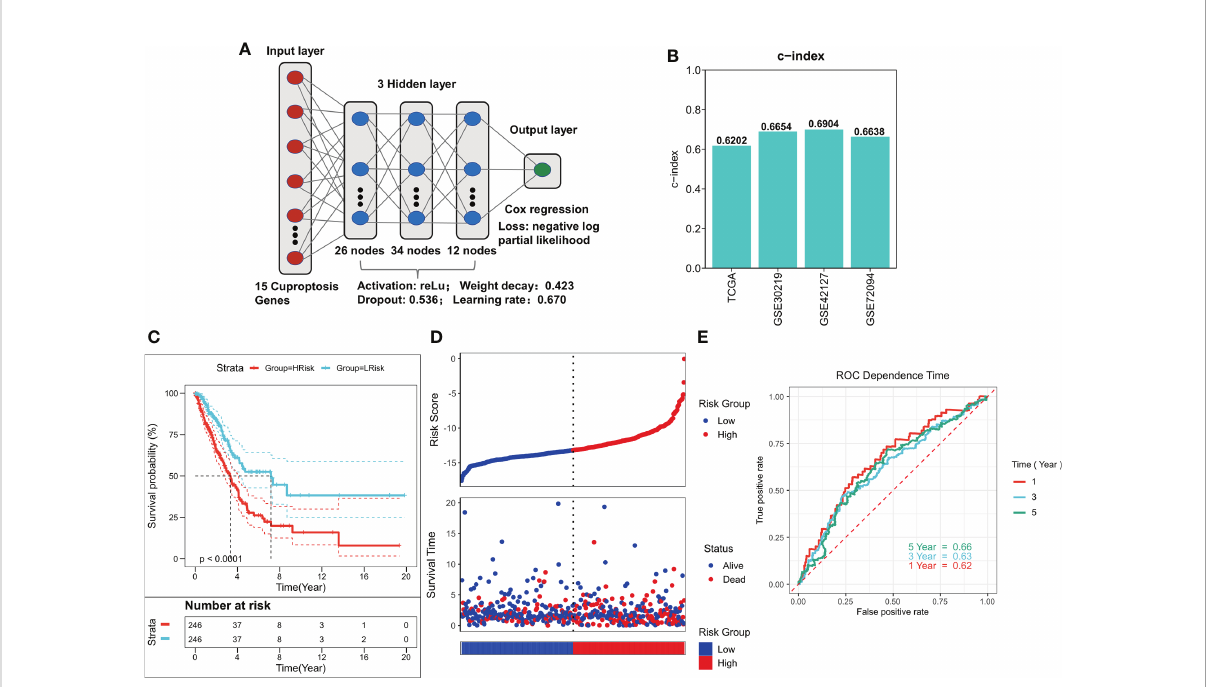
FIGURE 3 Construction of deep learning model related to CRGs. (A) Schematic diagram of the optimum ANN model. (B) C-INDEX of the optimum ANN model in the TCGA and GEO cohorts. (C) KM survival curves of the high-risk and low-risk groups in the TCGA cohort. (D) Survival status of patients in the TCGA cohort. (E) ROC curves of risk score at 1, 3, 5, and 8 years in the TCGA